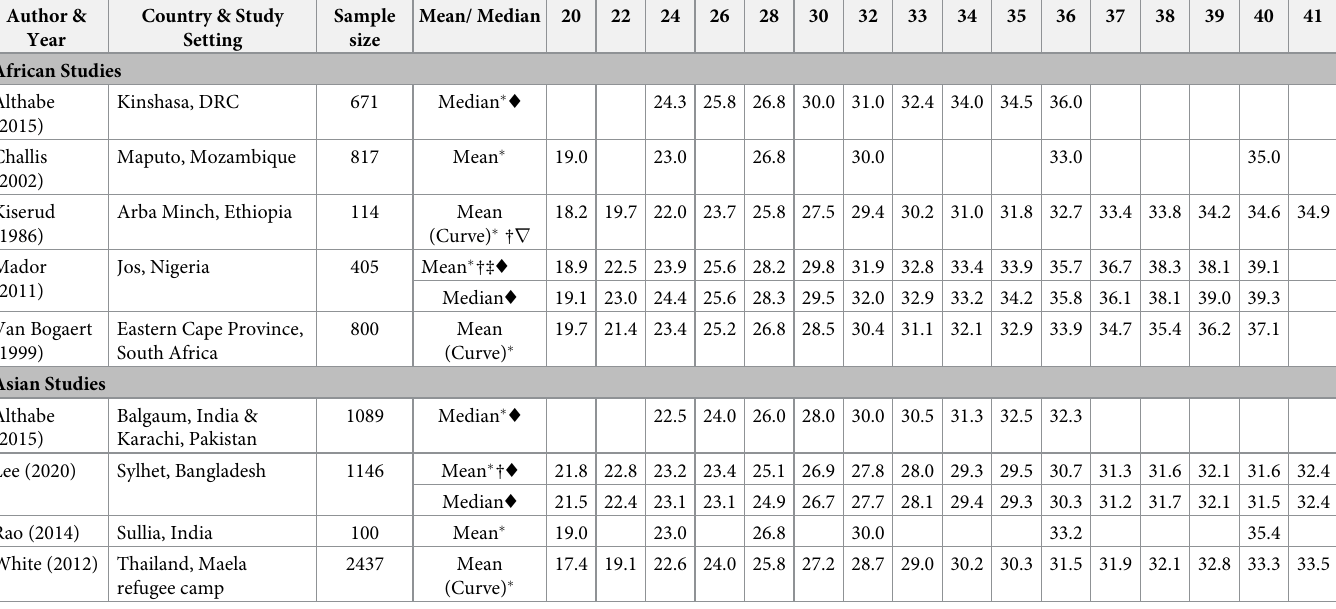
Table 2. Population-based reference data of SFH measurements (cm) by ultrasound confirmed gestational age (weeks) dates in low-middle income